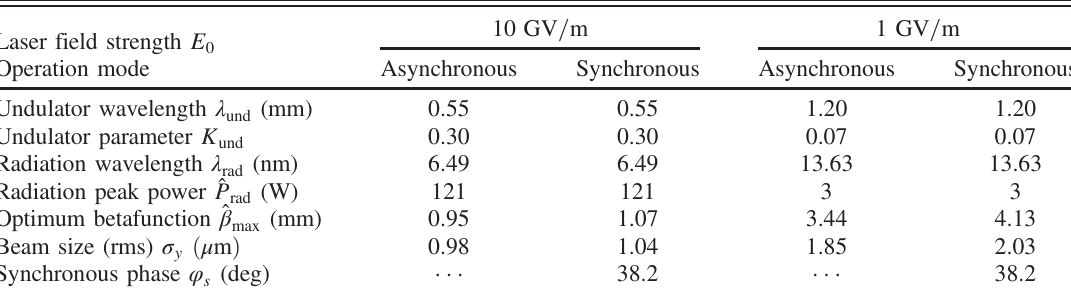
TABLE I. Specifications of both DLA undulator designs for the DESY-ARES accelerator. The damage threshold of the silica grating limits the drive-laser amplitude to E 0 ¼ 10 GV = m. The values at E 0 ¼ 1 GV = m serve for